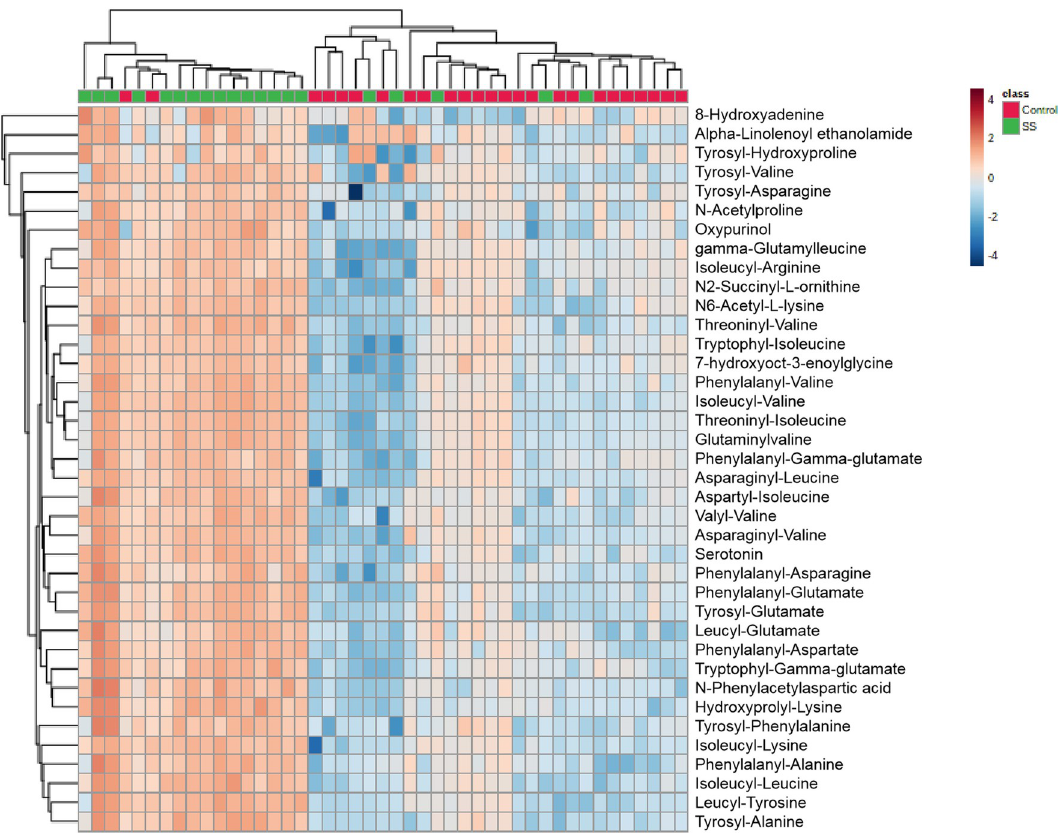
Fig 4. Relative intensity of differential metabolites in pSS subjects and healthy